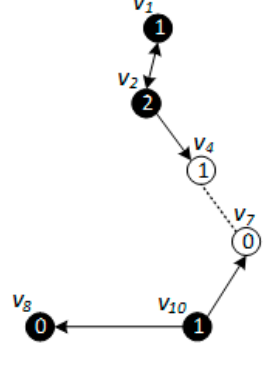
Figure 14. Broadcast backbone for ABRCD. Table 3 Data packet dissemination using ABRCD.